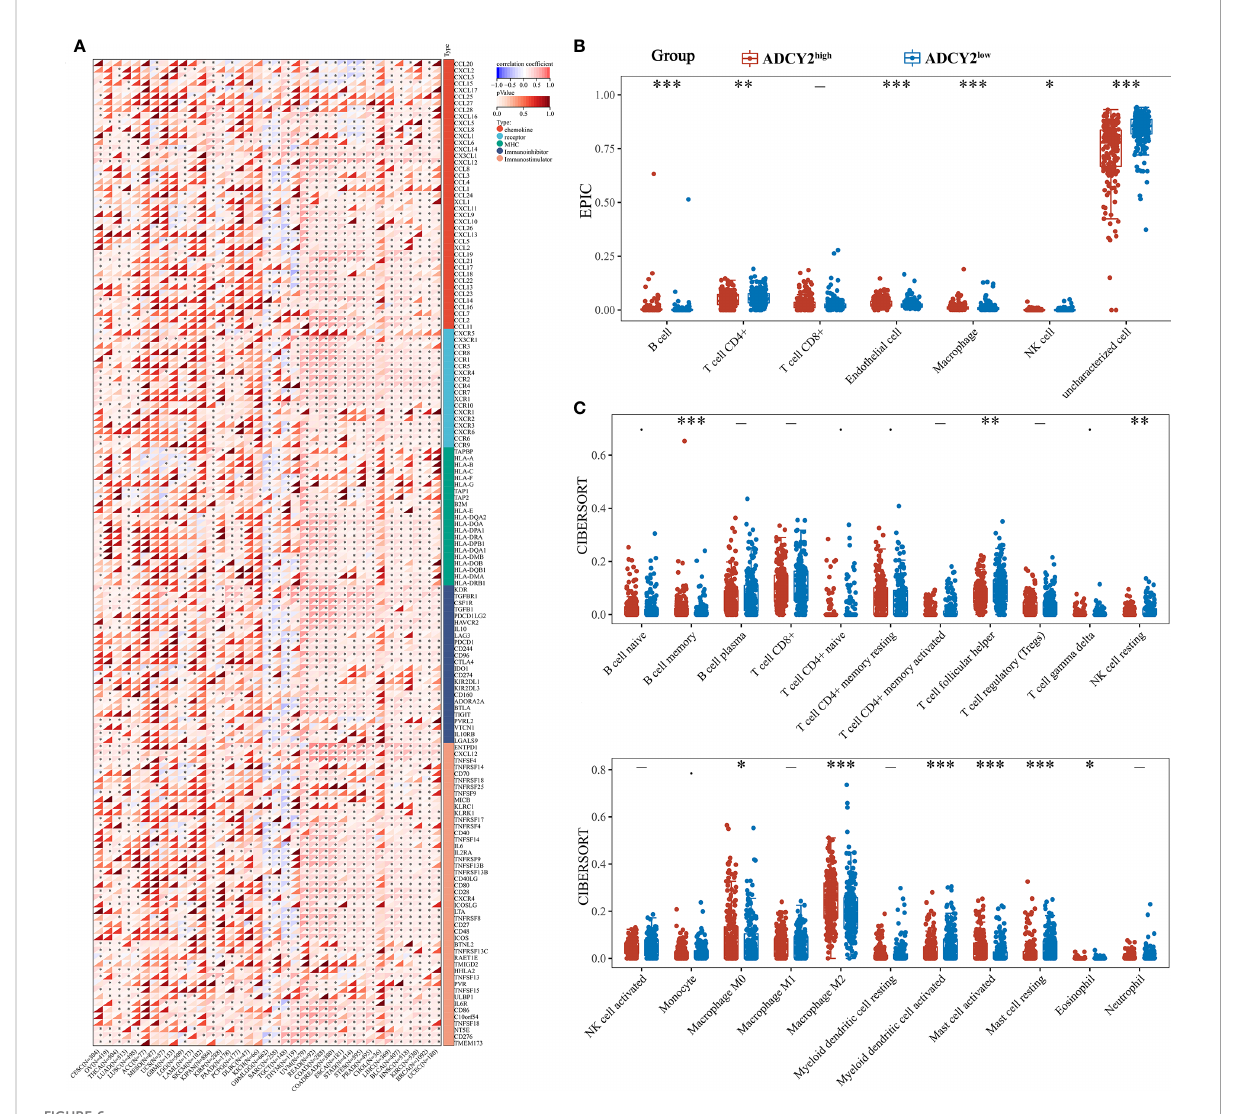
FIGURE 6 Implications of ADCY2 expression in immune regulators and tumor-in fi ltrated lymphocytes of cancers. (A) Correlation between ADCY2 and several immune-related cytokines in pan-cancer. (B, C) Immune in fi ltration difference analysis between high and low ADCY2 groups with EPIC and CIBERSORT algorithms. *p<0.05; **p<0.01;